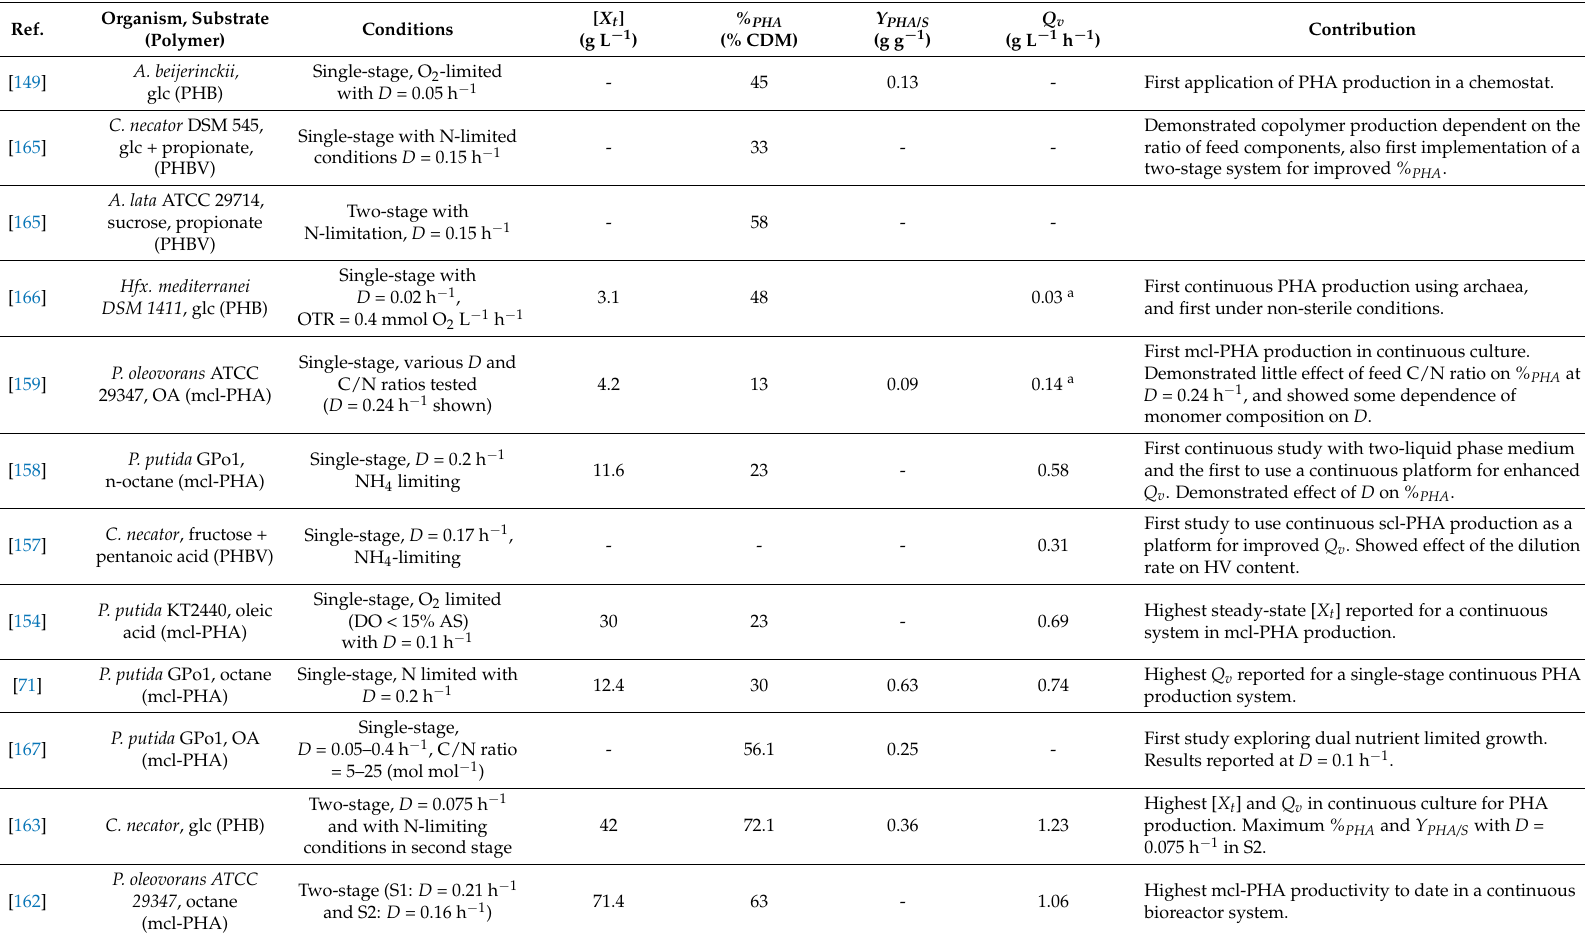
Table 5. Chronological summary of continuous culture studies in PHA